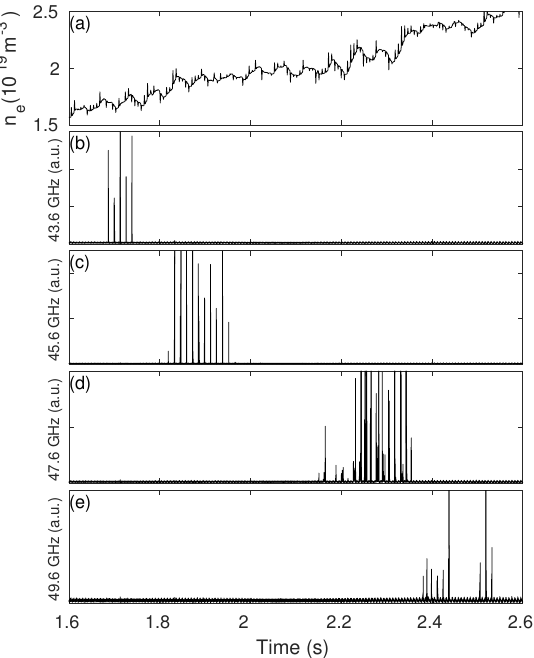
Figure 4: The frequency of the ω pe bursts changes as the electron density ramps up (EAST #70444): (a) line aver- aged electron density along a vertical chord close to the plasma center, (b)-(e) results of the Q-band radiometer system.